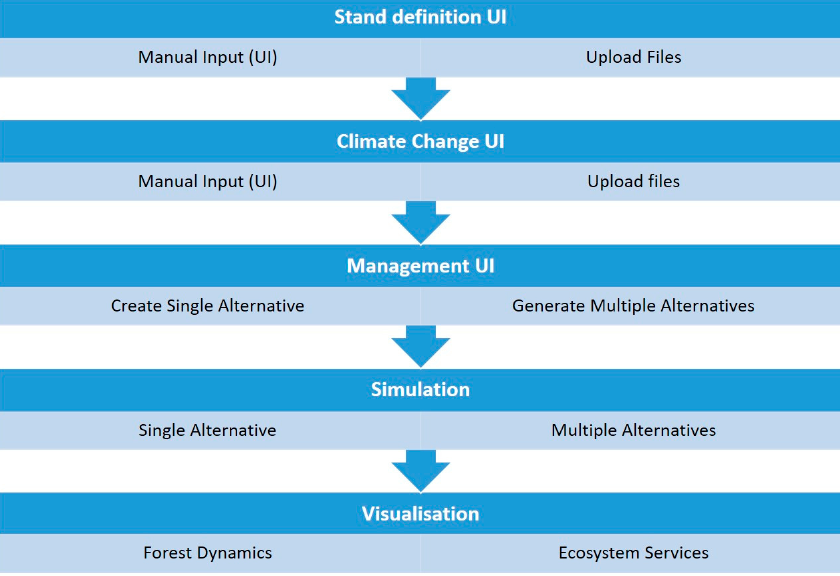
Figure 3. Graphical user interface (UI). The diagram shows the logical connection between interfaces, and the actions required to be performed on each interface /